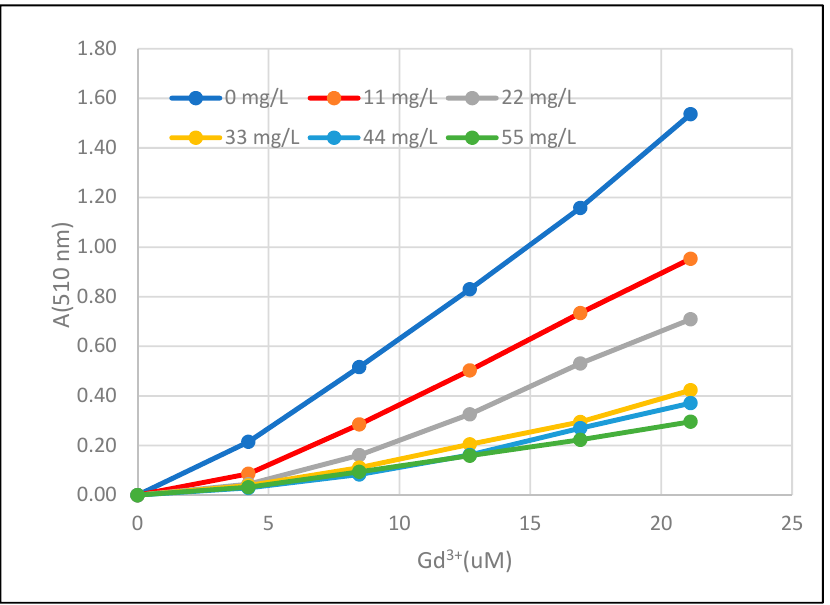
Figure 9. Summary of the titration of Fluka humic acid at pH 8 and various concentrations with Gd 3 + . The finite complexing capacity of the humic acid is apparent.